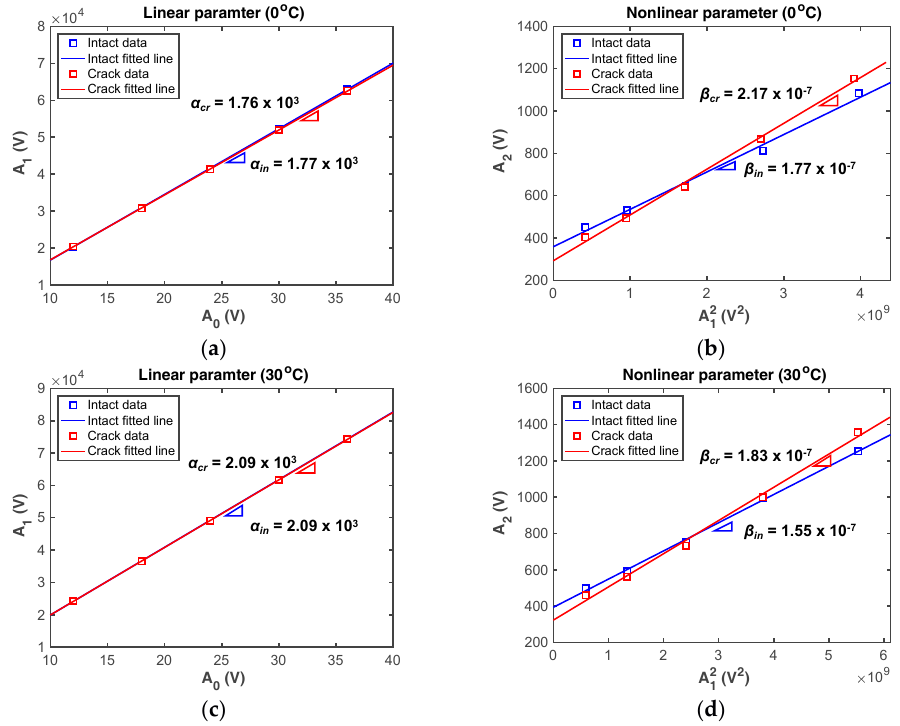
Figure 10. Comparison of representative experimental results between intact and cracked samples tested at 0 °C and 30 °C: ( a , c ) α , ( b , d ) β . The subscripts in and cr denote intact and cracked conditions, respectively.